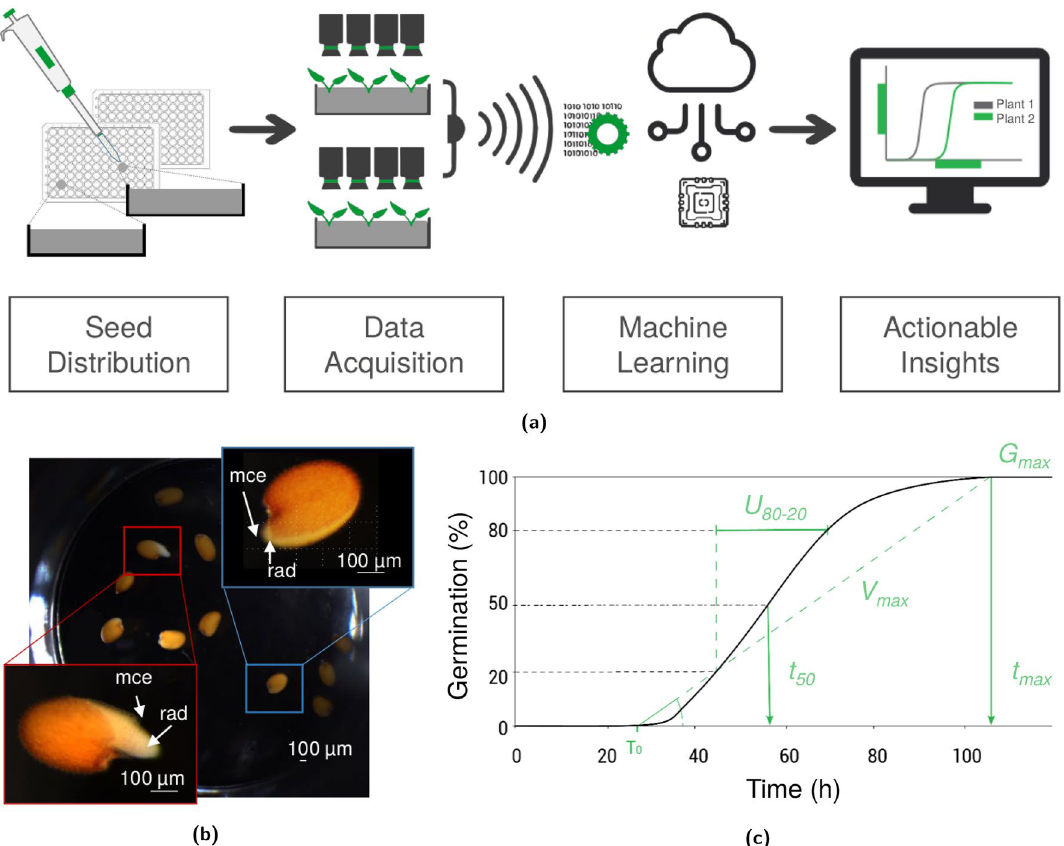
Figure 1. The ScreenSeed procedure workflow. ( a ) Seeds are sown by a pipetting method in microplates that are deposited in an automate (see Supplementary Fig. S1 online) taking hourly pictures of each well (see Supplementary Data S2 online). The images are transferred by Internet connection to a database for computational analysis and seed germination scoring. The software processing provides germination kinetics and extracts metrics with representation systems and statistical analyses that help to compare seed quality in a dashboard. ( b ) Imaging detection of germinated seeds. The imaging software was trained to score germinated seeds in microplate wells. In the microplate wells, the software identified germinated seeds (red square) among the detected seeds. A germinated seed illustrated by radicle protrusion through micropylar endosperm (see red square magnification details) is compared to non-germinated seed that only broke the testa but not the micropylar endosperm cap surrounding the radicle tip (see blue square magnification details). mce: micropylar endosperm; rad: radicle. The scale bar indicates 100 µ m . ( c ) Metrics of germination kinetics provided by the ScreenSeed dashboard. The kinetic curve is represented by cumulative germination percentage scored every hour during seed hydration. The metrics G max (maximal percentage of germination), U 80 − 20 (80/20 time spread it the time interval between 20% and 80% germination), t 50 (time required to reach 50% of the G max ) are automatically extracted from the database and can be compared between samples (Table